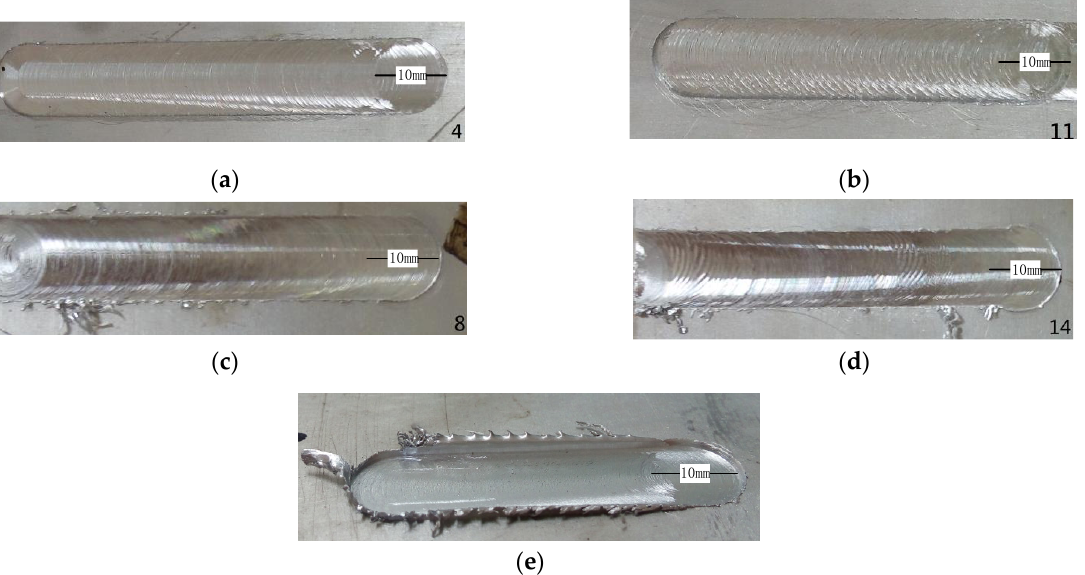
Figure 9. The finished workpiece with different initial temperatures: ( a ) finished workpiece with an initial temperature of 110.8 °C; ( b ) finished workpiece with an initial temperature of 200 °C; ( c ) finished workpiece with an initial temperature of 289.2 °C; ( d ) finished workpiece with an initial temperature of 350 °C; ( e ) finished workpiece with an initial temperature of 400 °C.